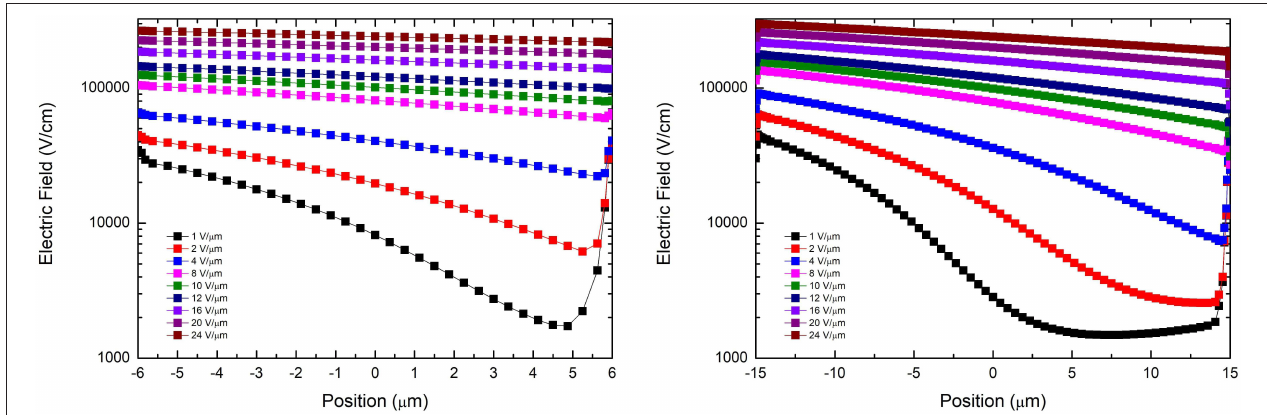
FIGURE 6 | Simulated distribution of the electric field within the 12 µ m thick n-i-p a-Si:H diode (left) and the 30 µ m thick n-i-p a-Si:H diode (right) as a cross section of the electric field distribution in the same device.